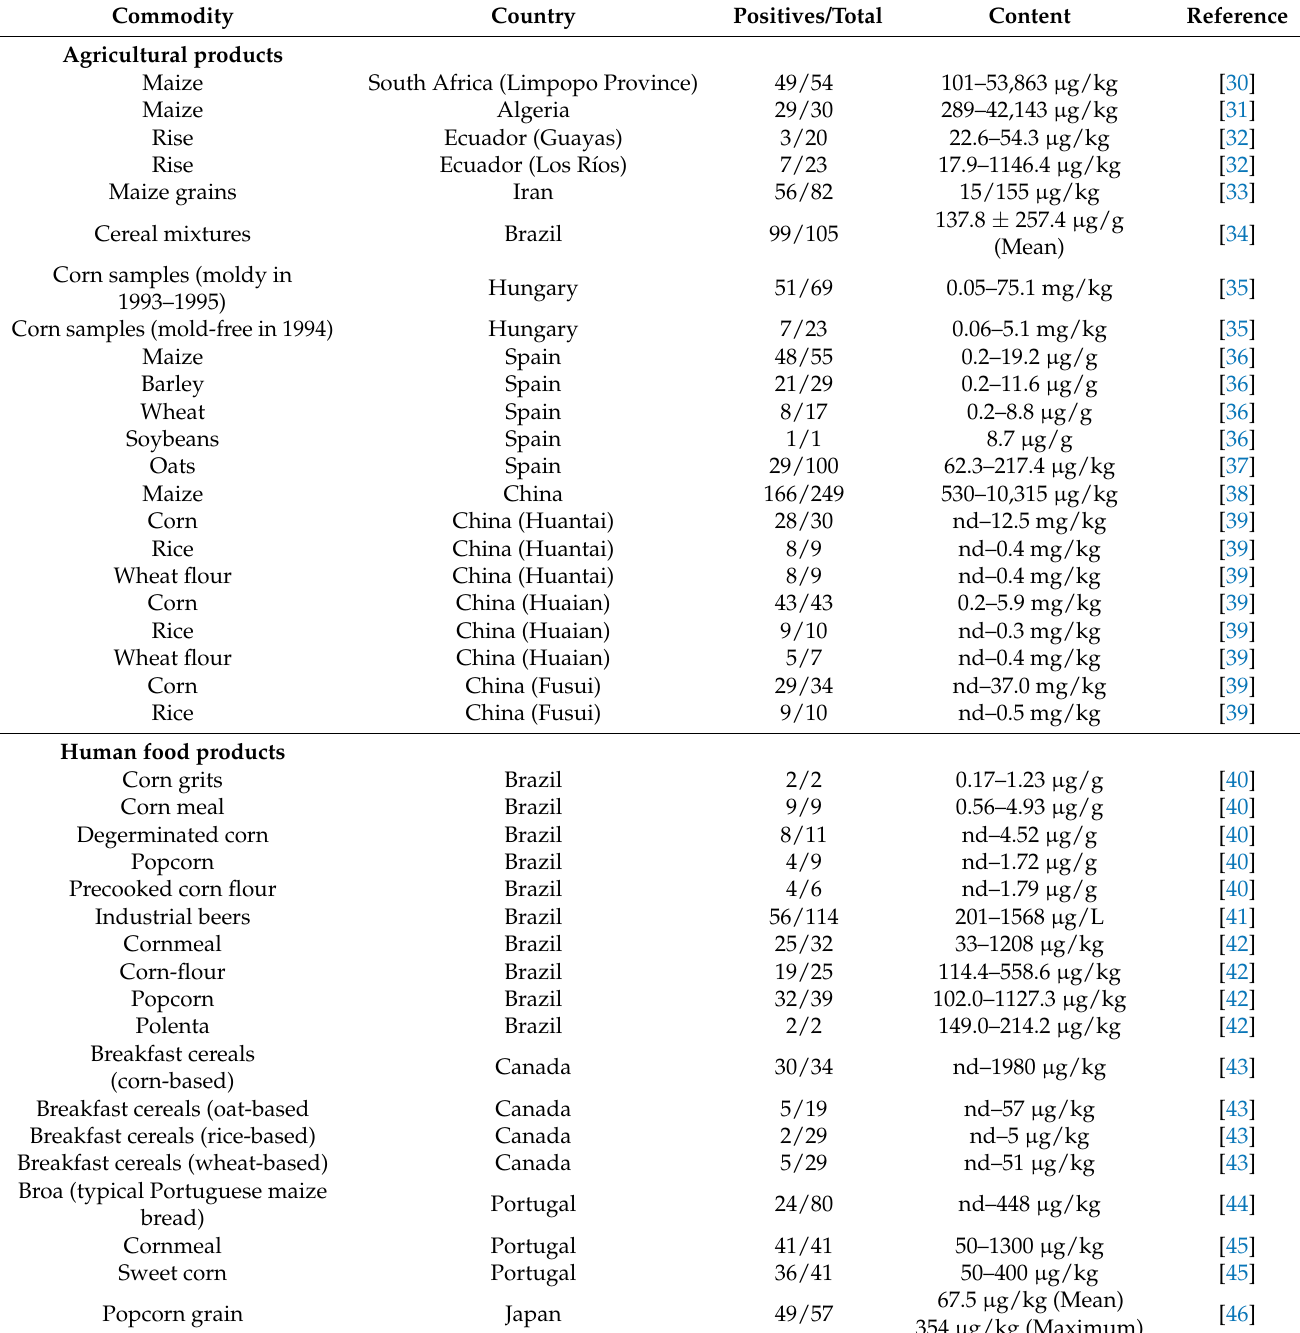
Table 1. Contamination of agricultural crops, human food, and animal feed by